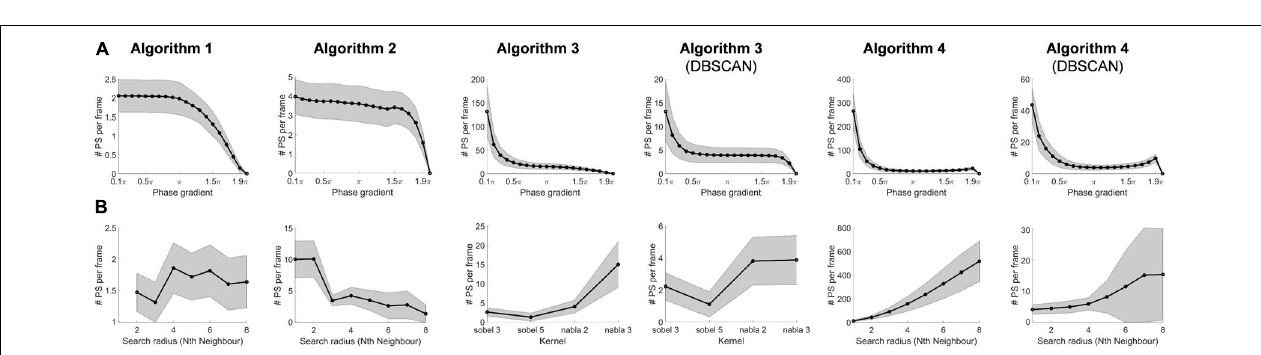
Figure 7B illustrates the processing time of all algorithms with search radius up to 8 circles of neighbors around the points of interest. Except for algorithm 3 and 3 + DBSCAN with kernels, the processing time increased with when more neighbors were included – with a power-law-like behavior for algorithms 1, 4, and 4 + DBSCAN. The overall processing time for PS detection for an average of 394.7 ms long 2048-channel VEGMs using optimal thresholds